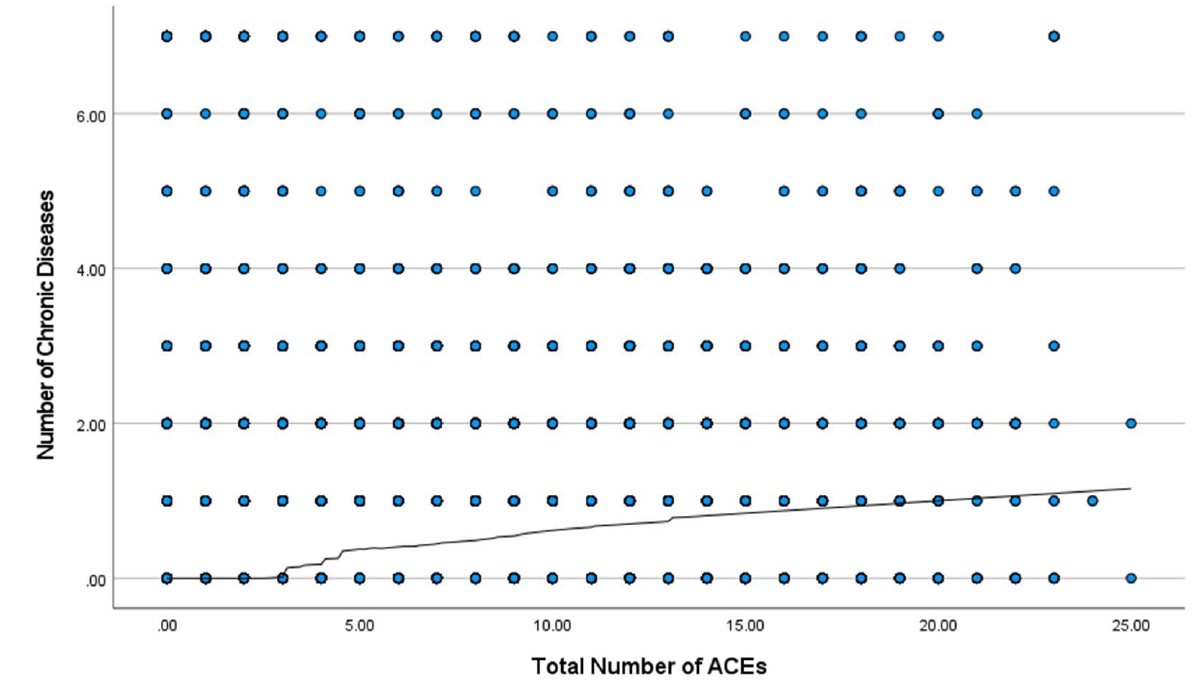
Figure 1. ACEs and chronic disease frequency.